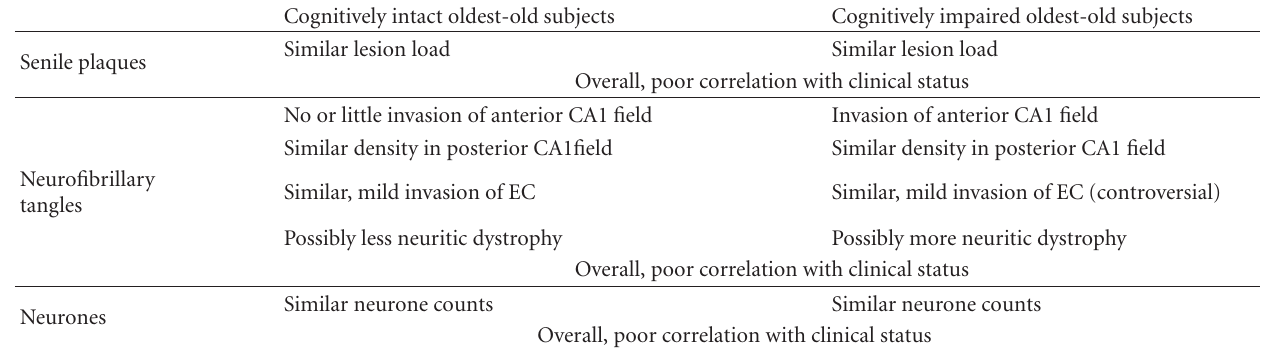
Table 2: Alzheimer’s disease pathology in the oldest-old with versus without cognitive